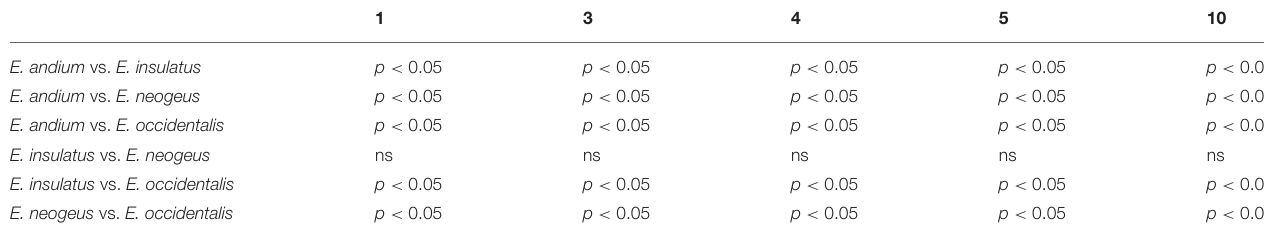
TABLE 1 | Kruskal-Wallis test results for comparative analysis of MTIII. 1 3 4 5 10